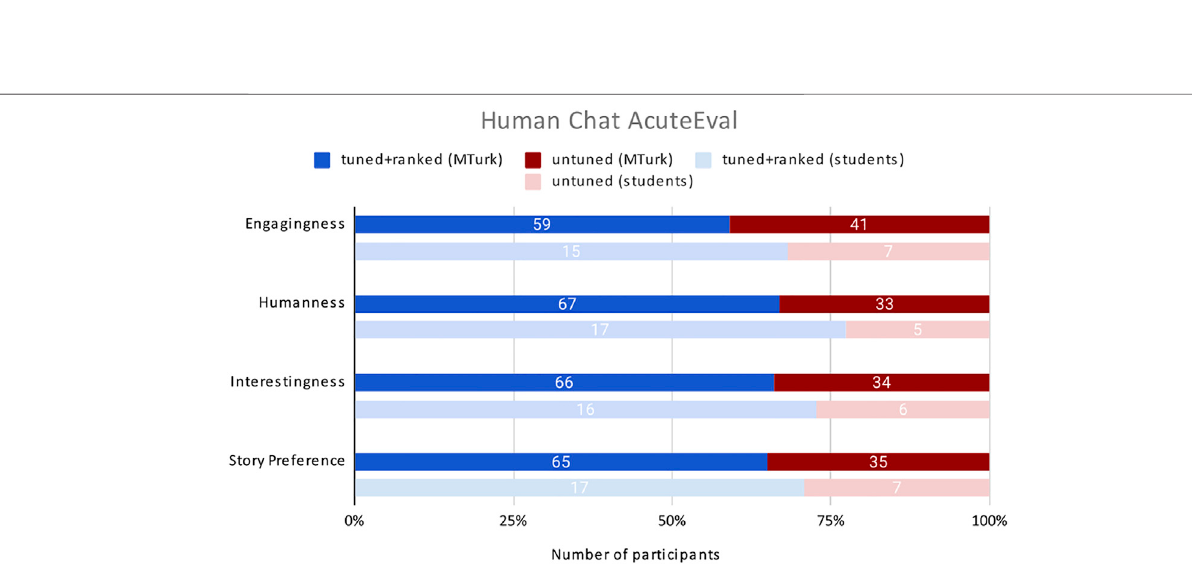
FIGURE 8 | Human evaluation of stories created with human collaborators, comparing our selected ranker ranker30 (here labeled tuned+ranked ) to an untuned baseline. The preferred system is indicated by a larger portion of the bar.